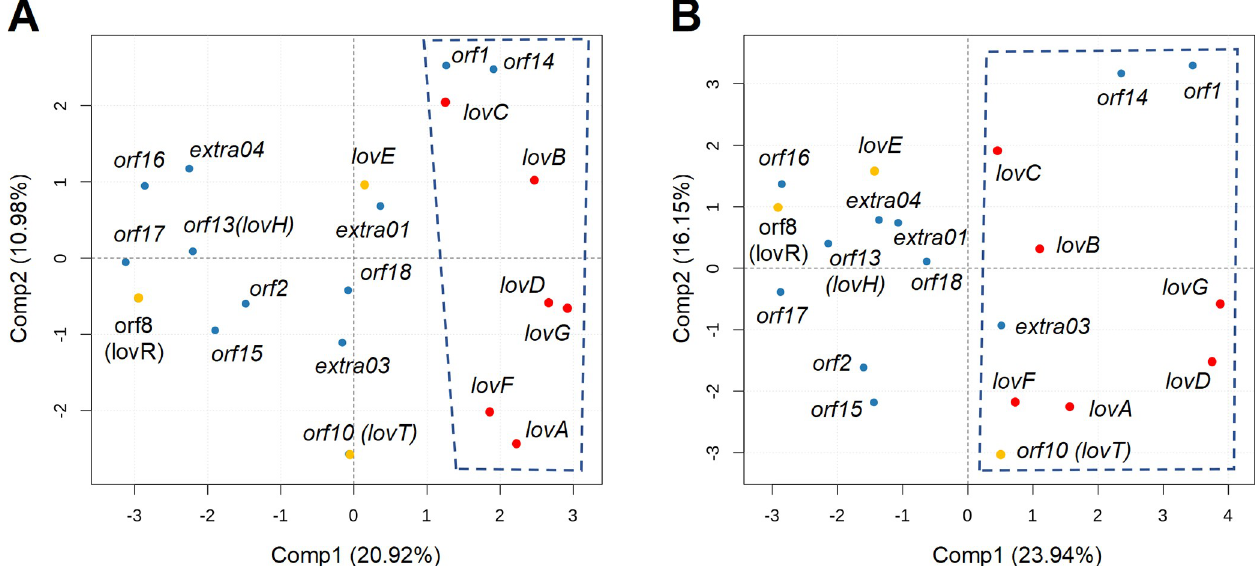
Fig 4. A selection of the standard output of the FunOrder analysis of the lovastatin BGC (lov). Score plots of the first two principal components from a PCA performed on the strict distance matrix (A) and on the combined distance matrix (B). The biosynthetic genes and the further essential genes are indicated in red and gold, respectively. Clusters in the PCA are indicated by the dashed